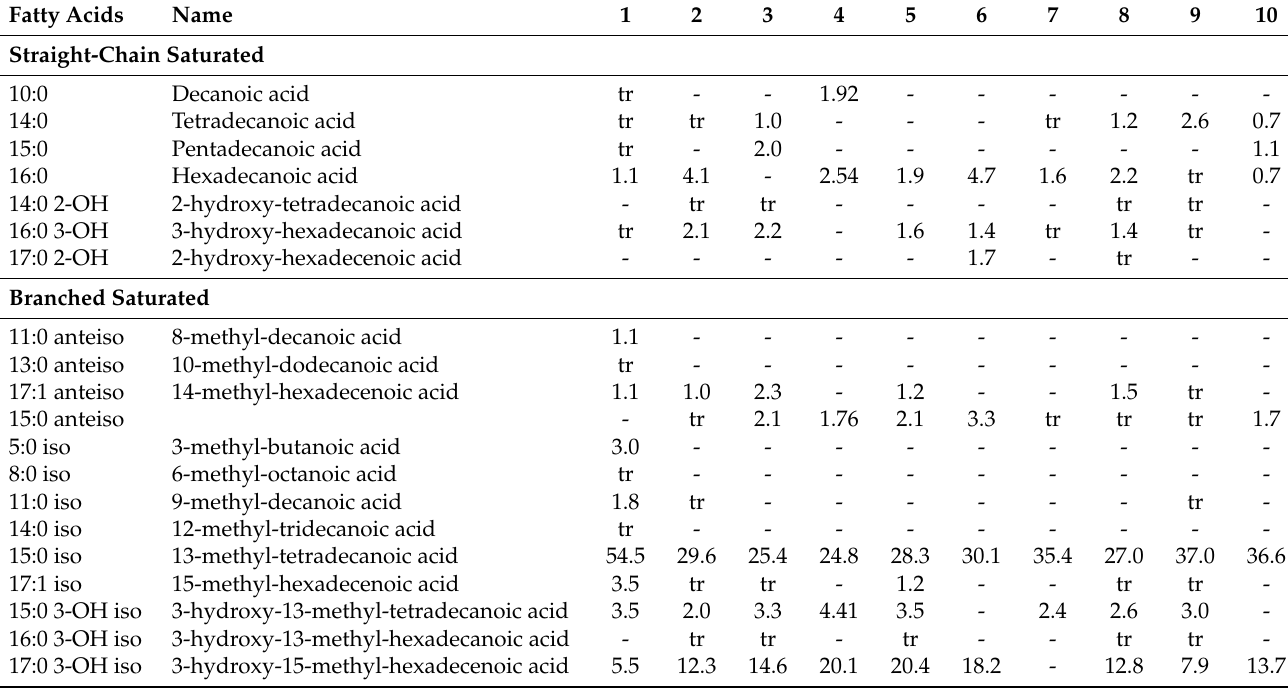
Table 7. Cellular fatty acid composition of strain Marseille-Q2390 and related species of the genus Pedobacter . Fatty